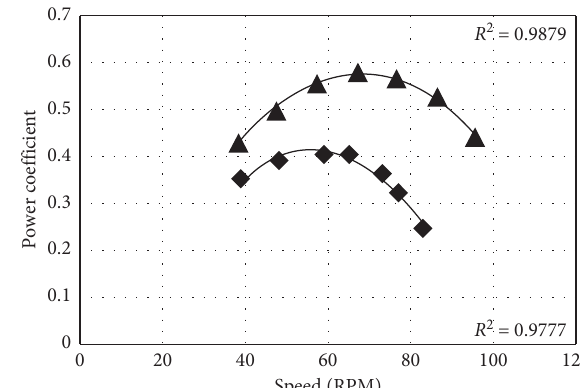
Figure 28: Runner 11 data points.